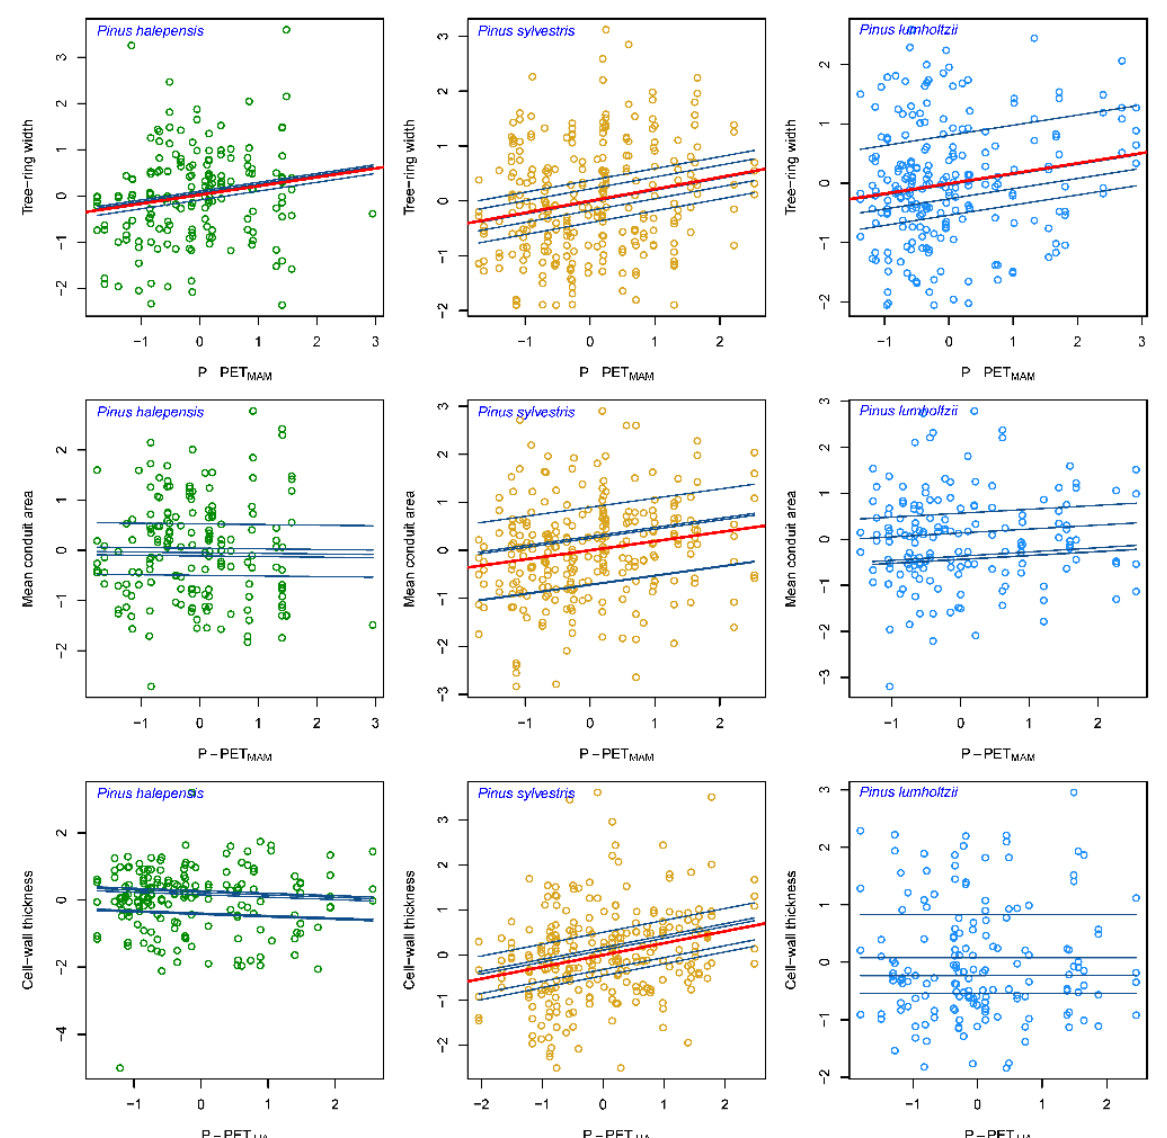
Figure 5. Model predicted relationships between the spring (P-PET MAM , for tree-ring width and mean conduit area) or summer water balance (P-PET JJA , for cell-wall thickness) and tree-ring width and wood anatomical traits. Red lines represent the population average fitted trend while blue lines represent the individual deviations from those group-level estimates. Missing red lines indicate non-significant effect of water balance (P-PET) on mean conduit area and cell-wall thickness.